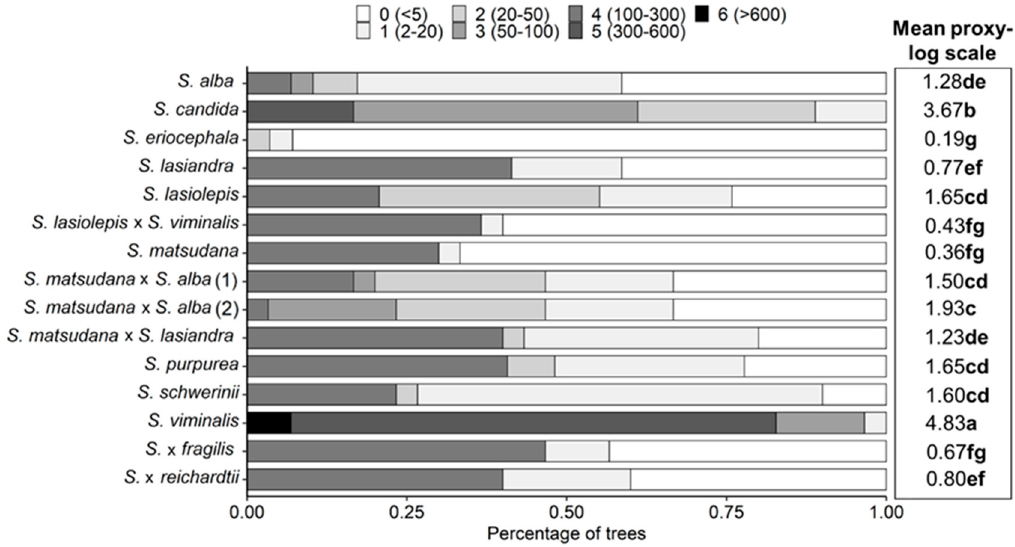
Figure 6. Proportion of willow plants hosting different population levels of T. salignus as monitored on 15 March 2019. The numbers on the right side represent mean proxy-log scales, with different letters indicating statistically significant differences among species; Tukey’s HSD test, α = 0.05.